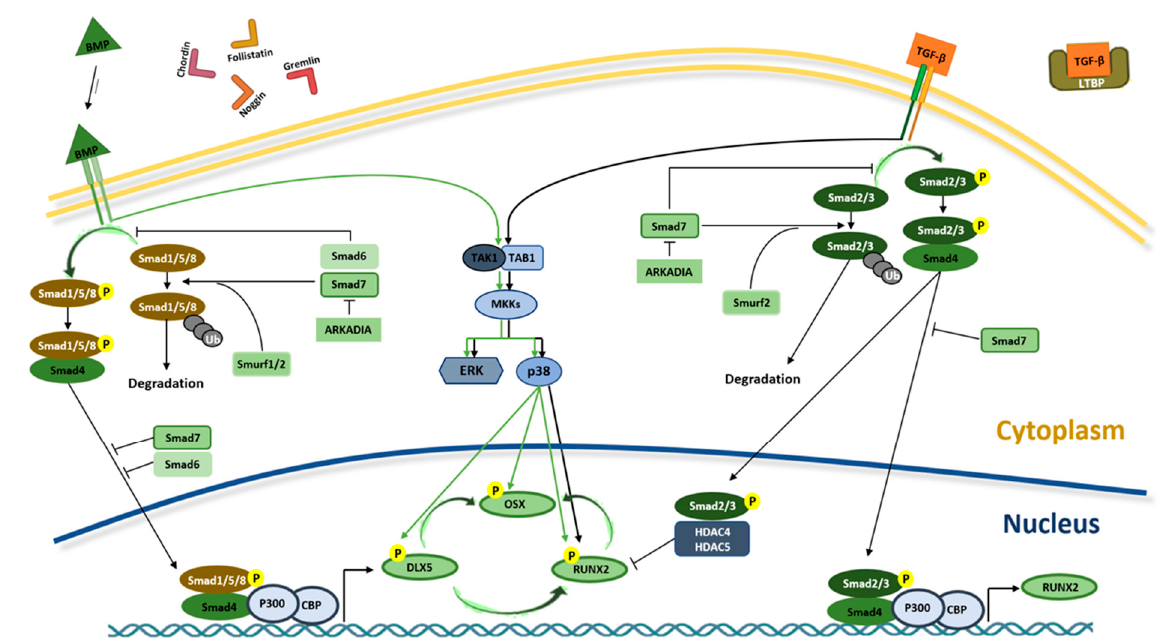
Figure 2. BMPs and TGF- β signaling pathways in osteogenesis. Interaction between TGF- β s and BMPs and receptors initiate SMAD-dependent and non-SMAD-dependent signaling pathways. In SMAD-dependent signaling pathway, interaction between TGF- β and receptor leads to SMAD2/3 (R-SMAD) phosphorylation. Phosphorylated R-SMAD (SMAD2/3-Pi) binds SMAD4 protein and migrates to the nucleus of the cell where, alongside P300 and CREB-binding protein (CBP) coactivators, it controls RUNX2 expression. In the nucleus, SMAD2/3-Pi without SMAD4 recruits HDAC4 and HDAC5 and blocks RUNX2 activity. In BMP signaling, R-SMAD (SMAD1/5/8) binds SMAD4 and migrates to the nucleus, inducing RUNX2 and OSX expression through DLX5 activation. In the non-SMAD-dependent signaling pathway, TAK1 and TAB1 activate the MKKs p38 MAPK or Erk cascades, inducing DLX5, RUNX2 and OSX phosphorylation. The interaction between TGF- β and its receptor is blocked by the latent TGF- β binding protein (LTBP), which binds to TGF- β . Similarly, in order to prevent the BMP–receptor interaction, Gremlin, Chordin, Follistatin and Noggin proteins bind to BMP. The translocation of SMAD2/3 and SMAD1/5/8 into the nucleus is prevented by SMAD7 that, along with SMURF1/2, induce their proteasome-mediated degradation. In addition, the binding between ARKADIA and SMAD6/7 proteins positively regulates osteoblast differentiation.